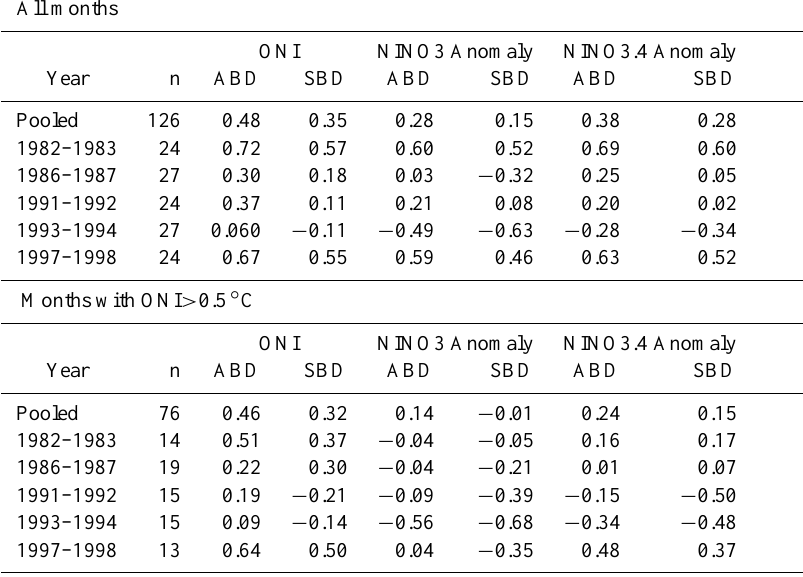
Table 2. Correlation ( r ) between monthly El Ni˜no strength (as measured by the ONI, NINO3, and NINO3.4 SST anomaly-based indices) and Borneo’s rainfall deficit across the whole island (ABD) and just the south of the island (SBD) during the five El Ni˜nos studied here; the two most significant in terms of El Ni˜no strength being those of 1982–1983 and 1997–1998. Results are shown for individual events and all events pooled together, and including all months (total=126 across all years) and only those months meeting only the ONI ≥ 0.5 ◦ C criteria (Kousky and Higgins, 2007).